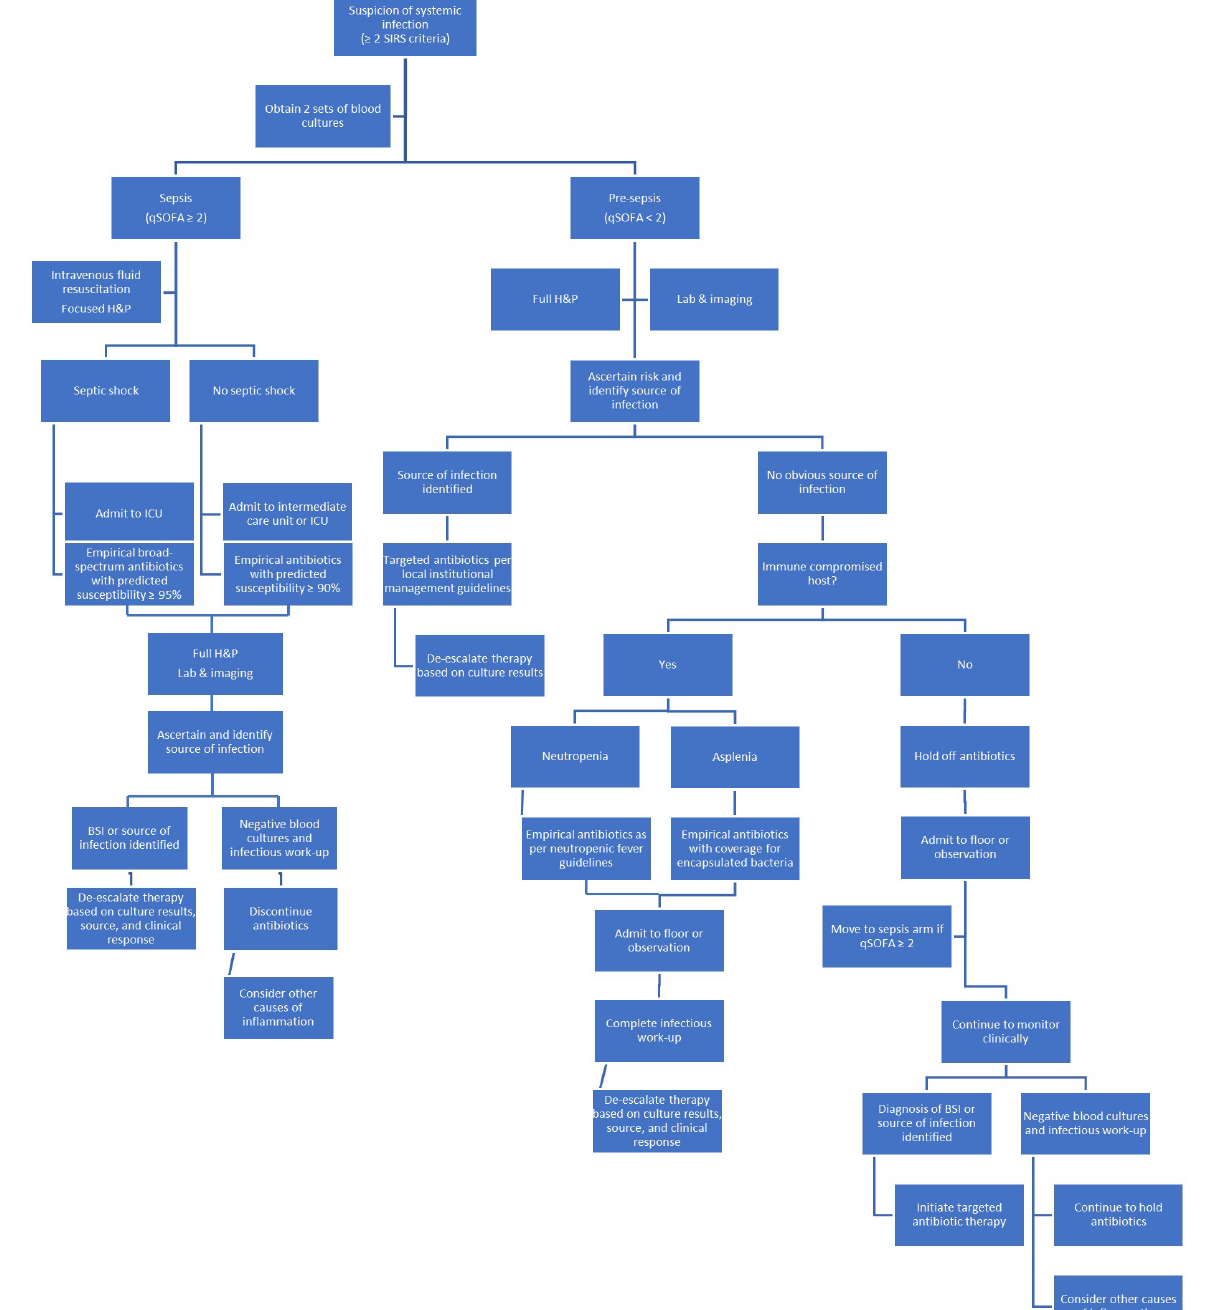
Figure 1. Proposed management algorithm in patients with suspected systemic infections. H: history; P: physical